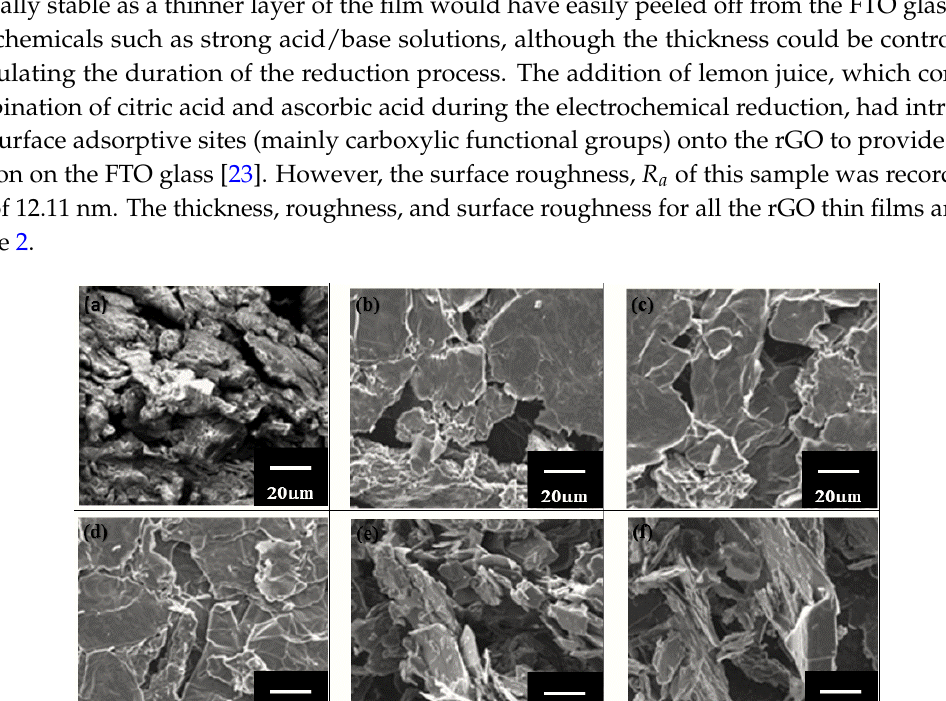
Figure 5. AFM topology of ( a ) 2D height, ( b ) 3D height, and ( c ) line profile of 15 V rGO thin film sample.